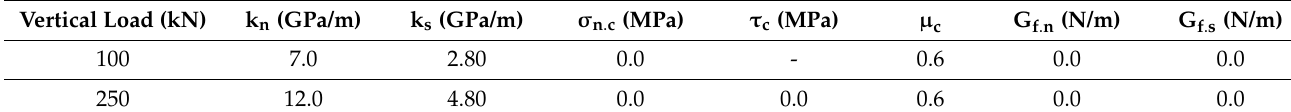
Table 3. Contact elastic and strength properties for dry shear wall.